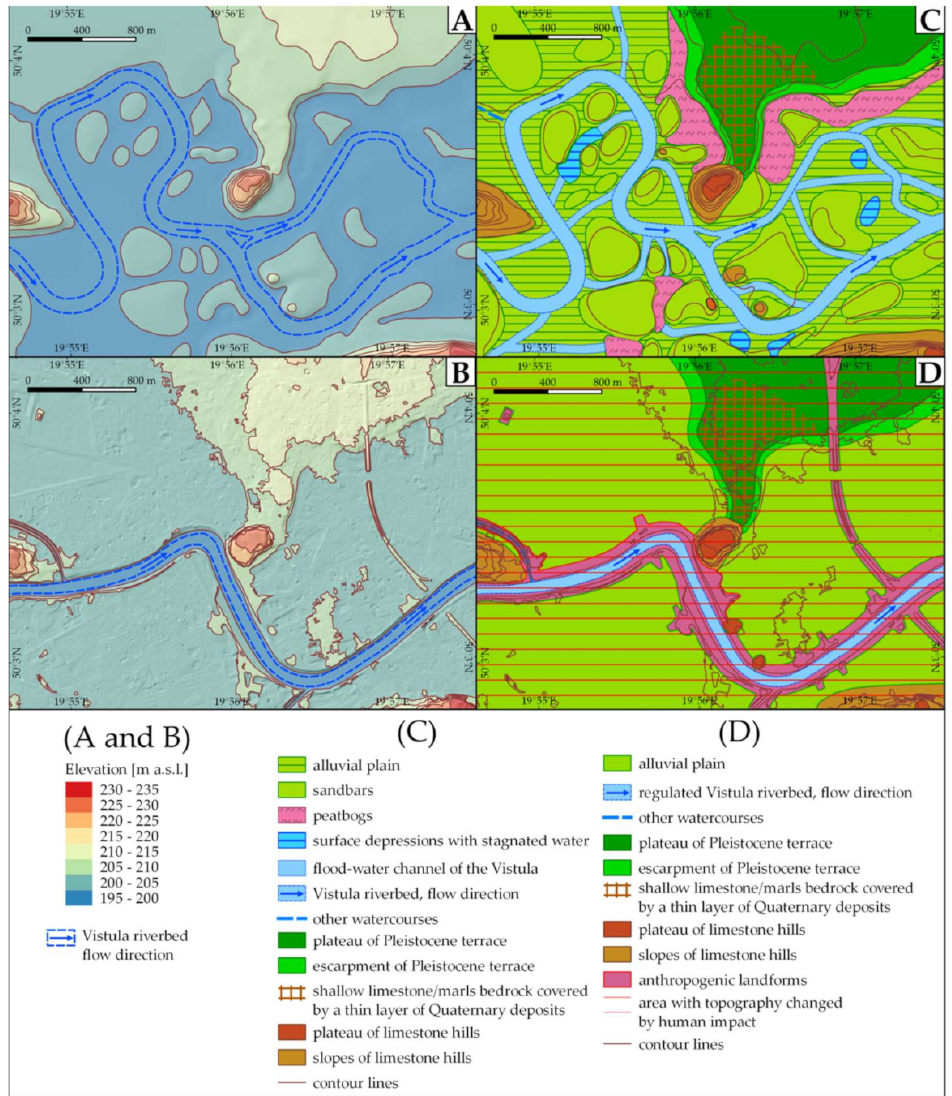
Figure 3. The topography of the area studied expressed by hypsometry in historical variant ( A ) and current variant ( B ) and by distribution of landforms in historical variant ( C ) and current variant ( D ) [12,24]. Explanations in the